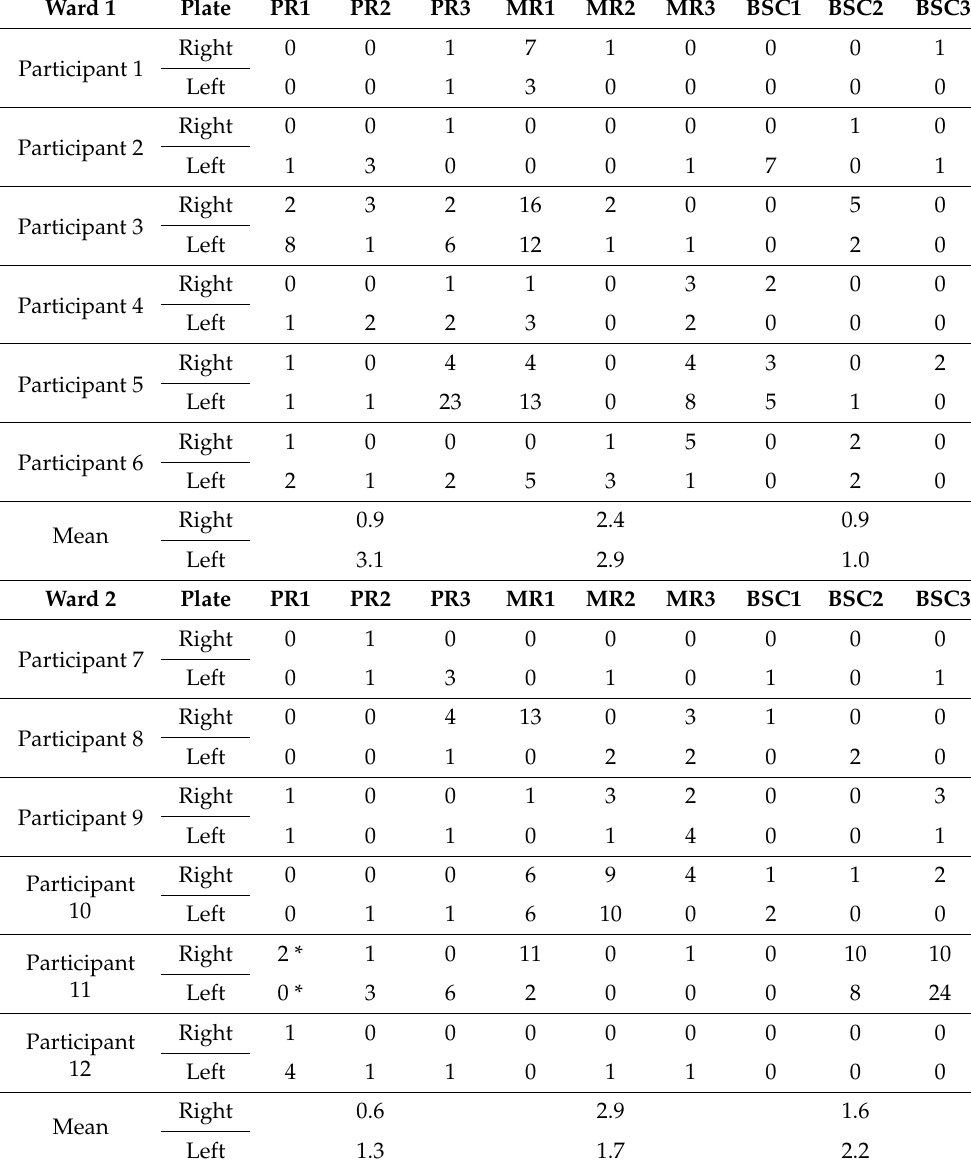
Table 3. Results of the finger dab plates (N = 216). Results are presented as